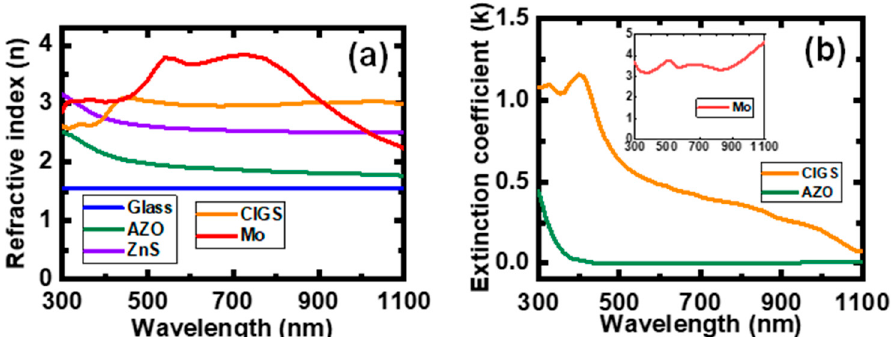
Figure 2. Complex refractive index spectra of the materials used in the CIGS solar cell, of which the real and imaginary parts are ( a ) the refractive index ( b ) extinction coefficient, respectively.